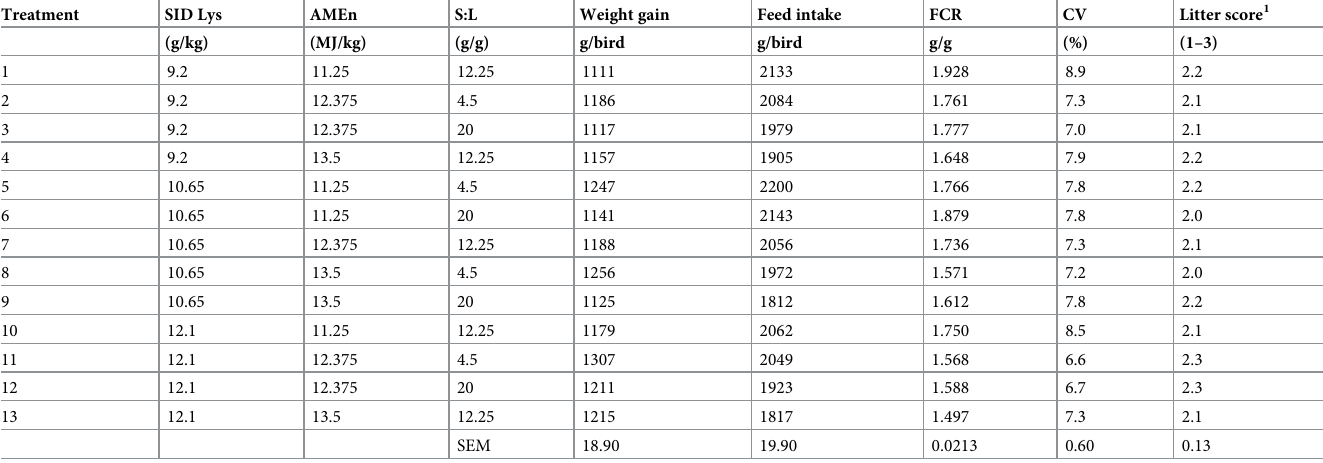
Table 5. Effects of dietary treatment on growth performance from 21–35 days post-hatch and flock uniformity and litter score at 35 days post-hatch.